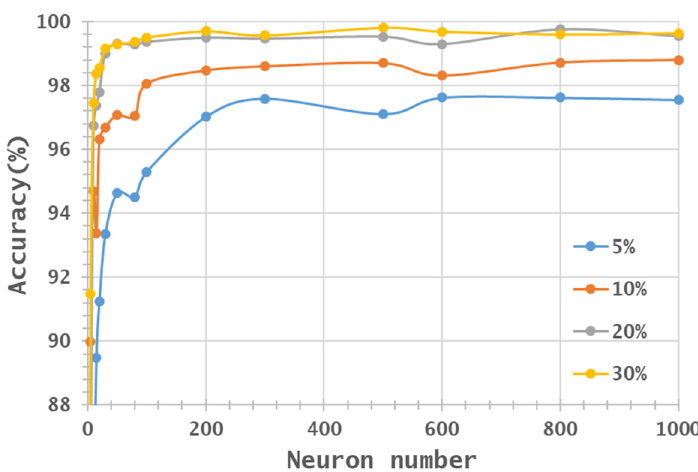
Figure 8. Accuracy distribution of IP MNF1–14 + HHT image set, varying with training sample proportion and hidden layers.